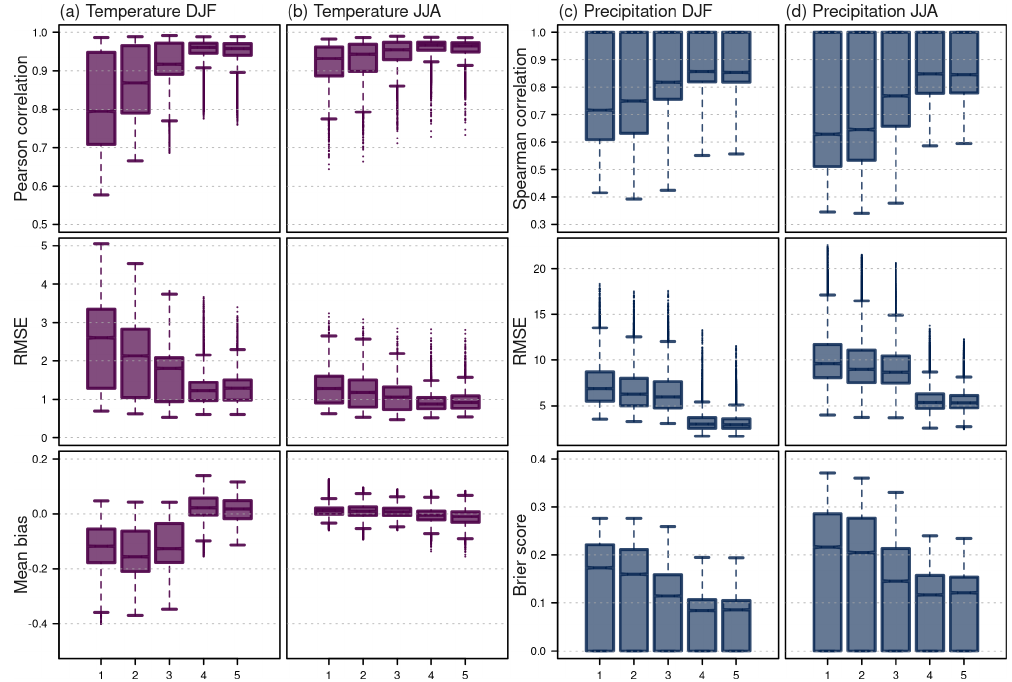
Figure 5. Cross-validation results for the five networks shown in Fig. 1 for temperature anomalies during 1961–2020 (a) in winter (DJF) and (b) summer (JJA), showing Pearson correlation, RMSE, and mean bias, and for precipitation (c) in winter (DJF) and (d) summer (JJA), showing Spearman correlation, RMSE, and Brier score.